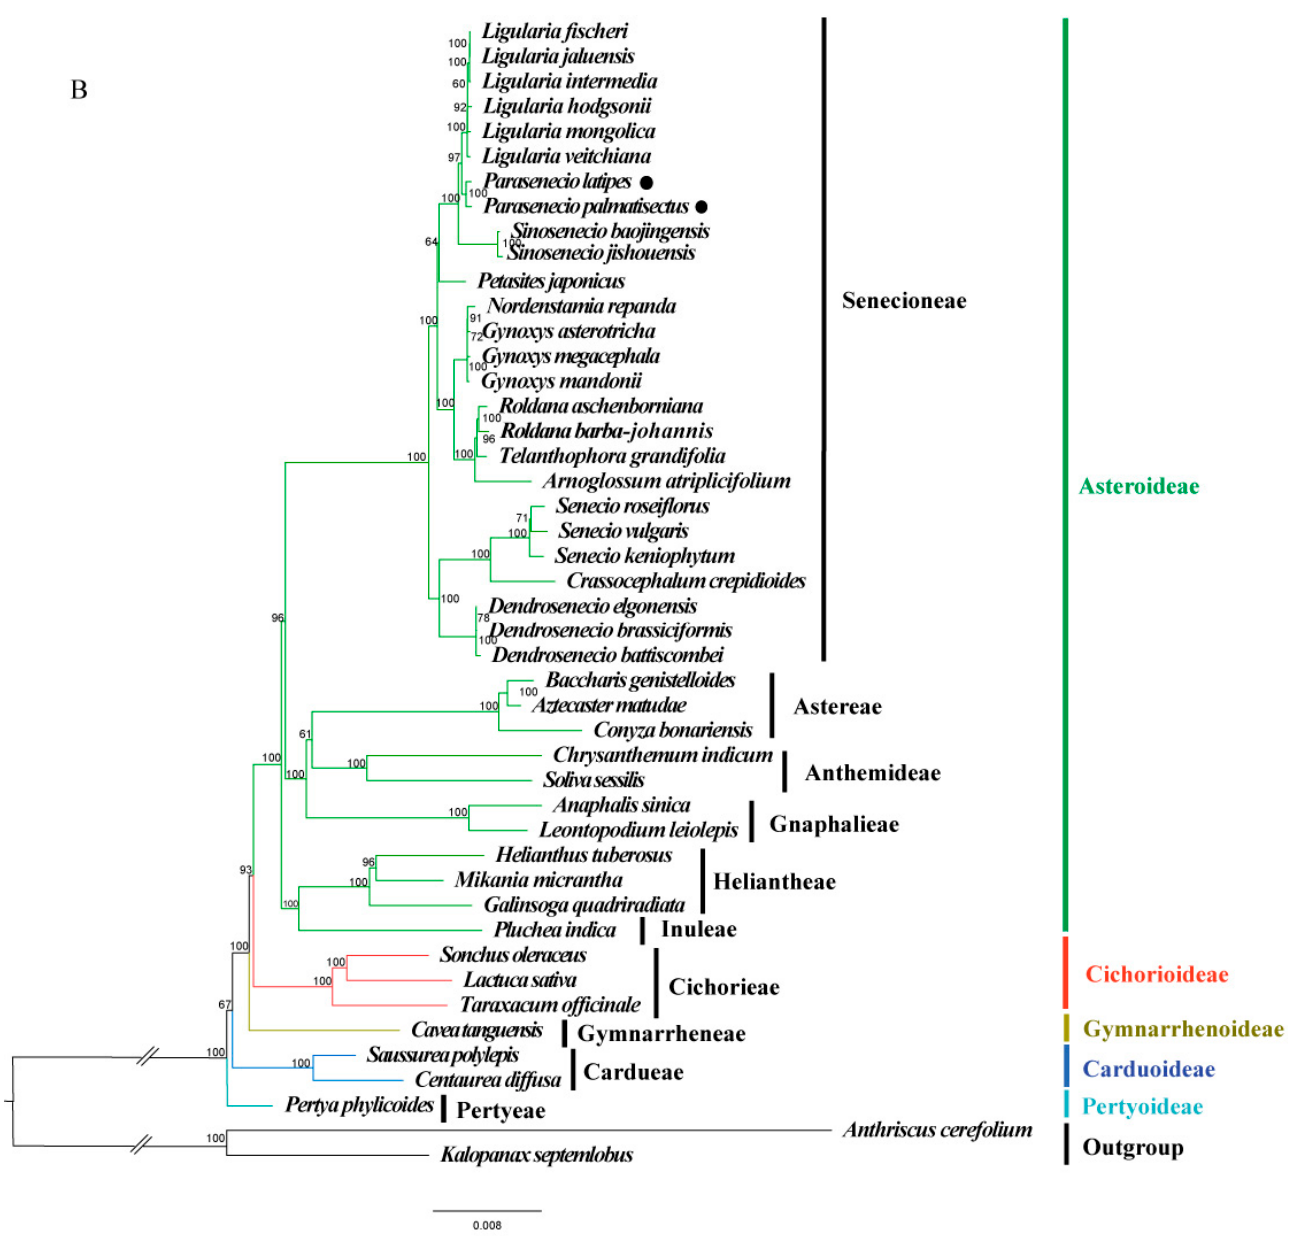
Figure 8. Phylogenetic tree reconstruction of 46 taxa using ML method based on ( A ) complete cp genomes and ( B ) the IGS sequence. Bootstrap support values are shown at the nodes. The phylogenetic position of Parasenecio species is marked with black circles.